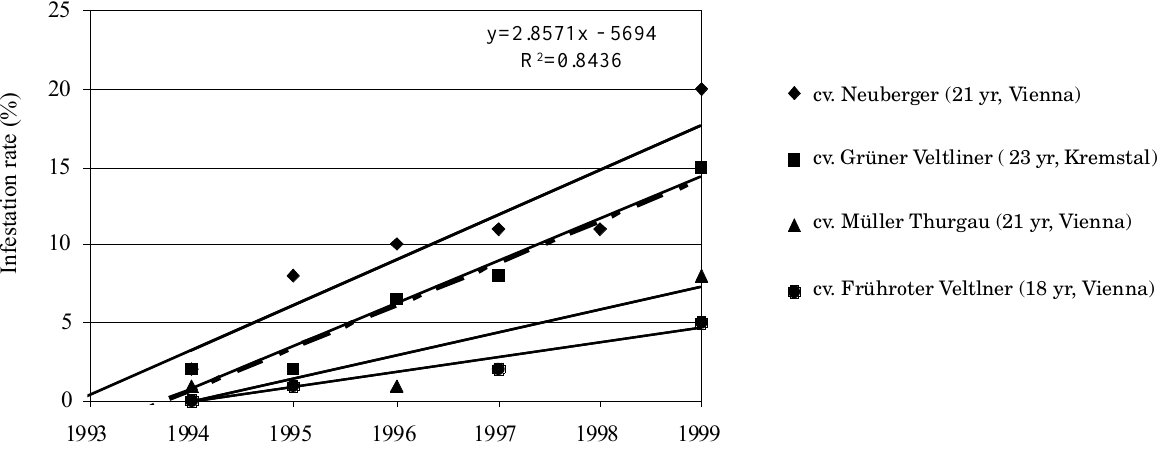
Fig. 6. The temporal dispersal of esca in four vineyards in the Vienna and Kremstal areas. The infection rate (percentage of vines with external symptoms per vineyard) increased annually by